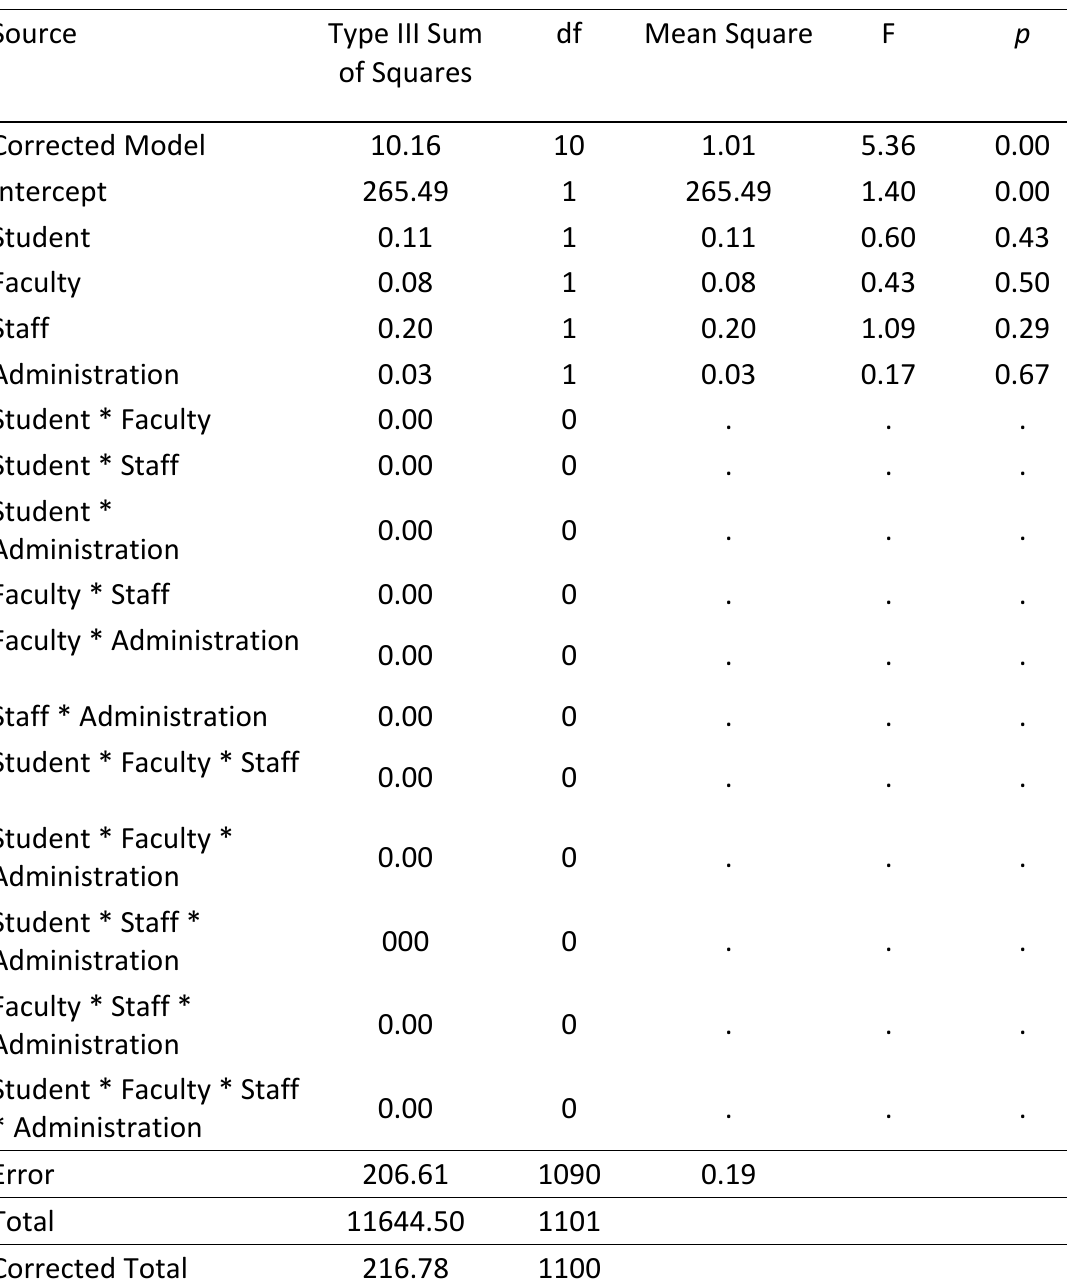
Tests of Between Subjects